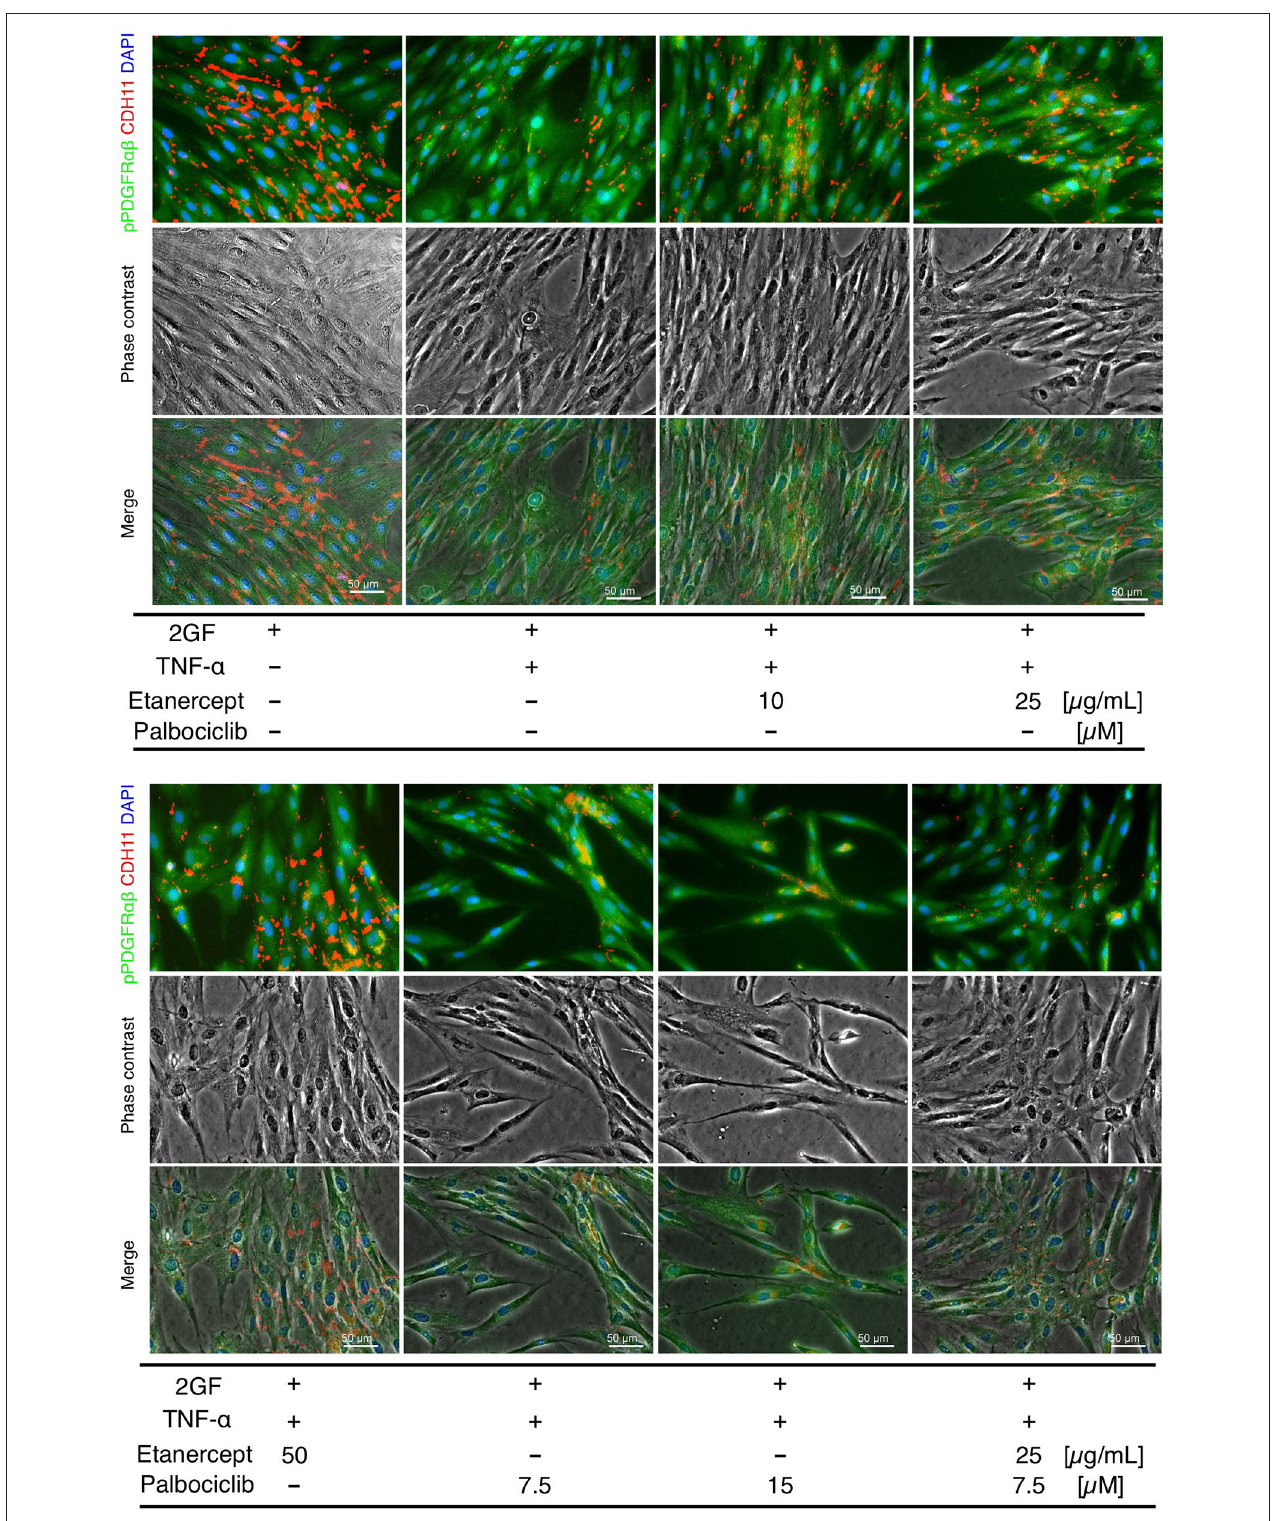
FIGURE 6 | pPDGFR αβ and CDH11 expression by 2GF + TNF and a TNF inhibitor (etanercept) and a CDK4/6 inhibitor (palbociclib) in RA-FLSs. Representative images of immunostaining for pPDGFR αβ and CDH11 expression with FLSs stimulated with 2GF + TNF and the TNF and CDK4/6 inhibitors in each combination.